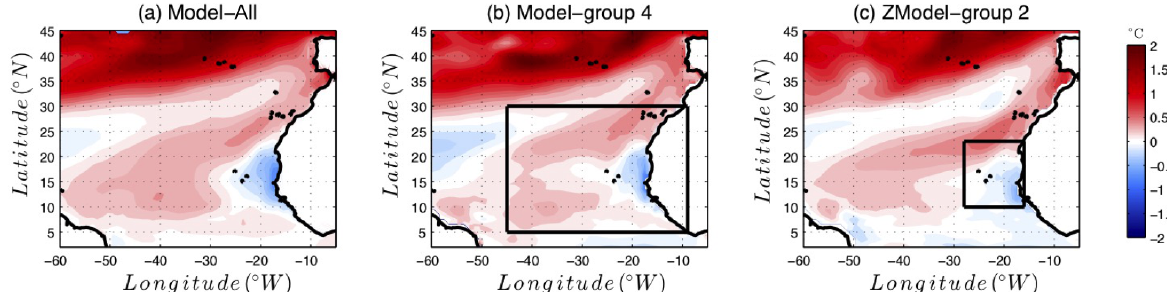
Figure 12. Evolution of the amplitude of the SST seasonal cycle at the end of the 21st century. The figure shows the difference between the seasonal cycle amplitude averaged over the period (2080–2100) following the RCP8.5 scenario and the amplitude averaged over the period (1985–2005) in the historical simulations. A positive value (red) means that the seasonal cycle is more marked over the period